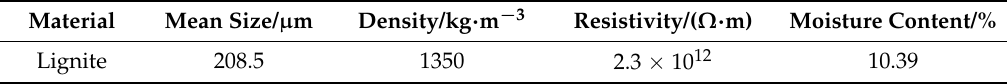
Figure 8. Schematic of a pneumatic conveying system of pulverized coal. Table 1. Properties of lignite coal particles.